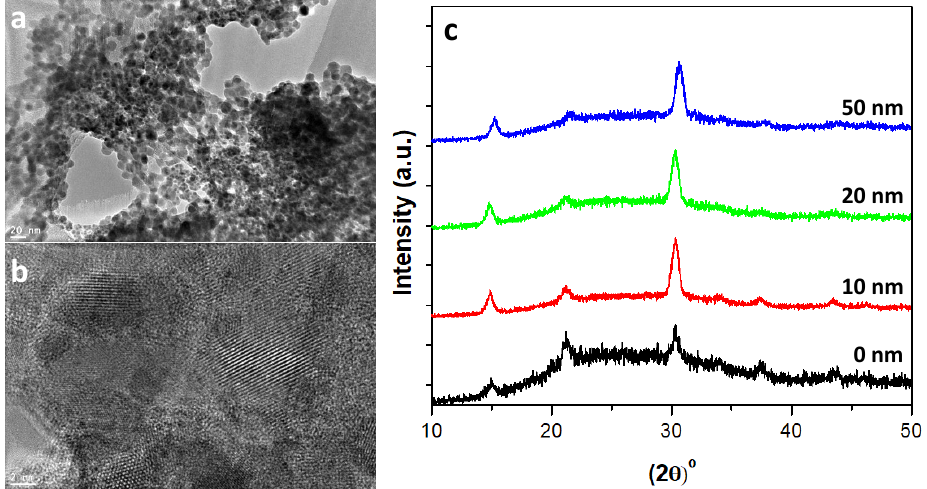
Figure 1. ( a ) TEM Image of the pure CsPbBr 3 PQDs film, ( b ) High-resolution TEM of the pure CsPbBr 3 PQDs film, and ( c ) XRD patterns of the parent spectra of the pure CsPbBr 3 PQDs and CsPbBr 3 PQDs/(c-TiO 2 ) films deposited on glass substrate with various thicknesses of 0, 10, 20, and 50 nm. Table 1. The calculated CsPbBr 3 QD sizes from XRD patterns using the Scherrer equation. c-TiO 2 Thickness (in nm) FWHM (in degree)